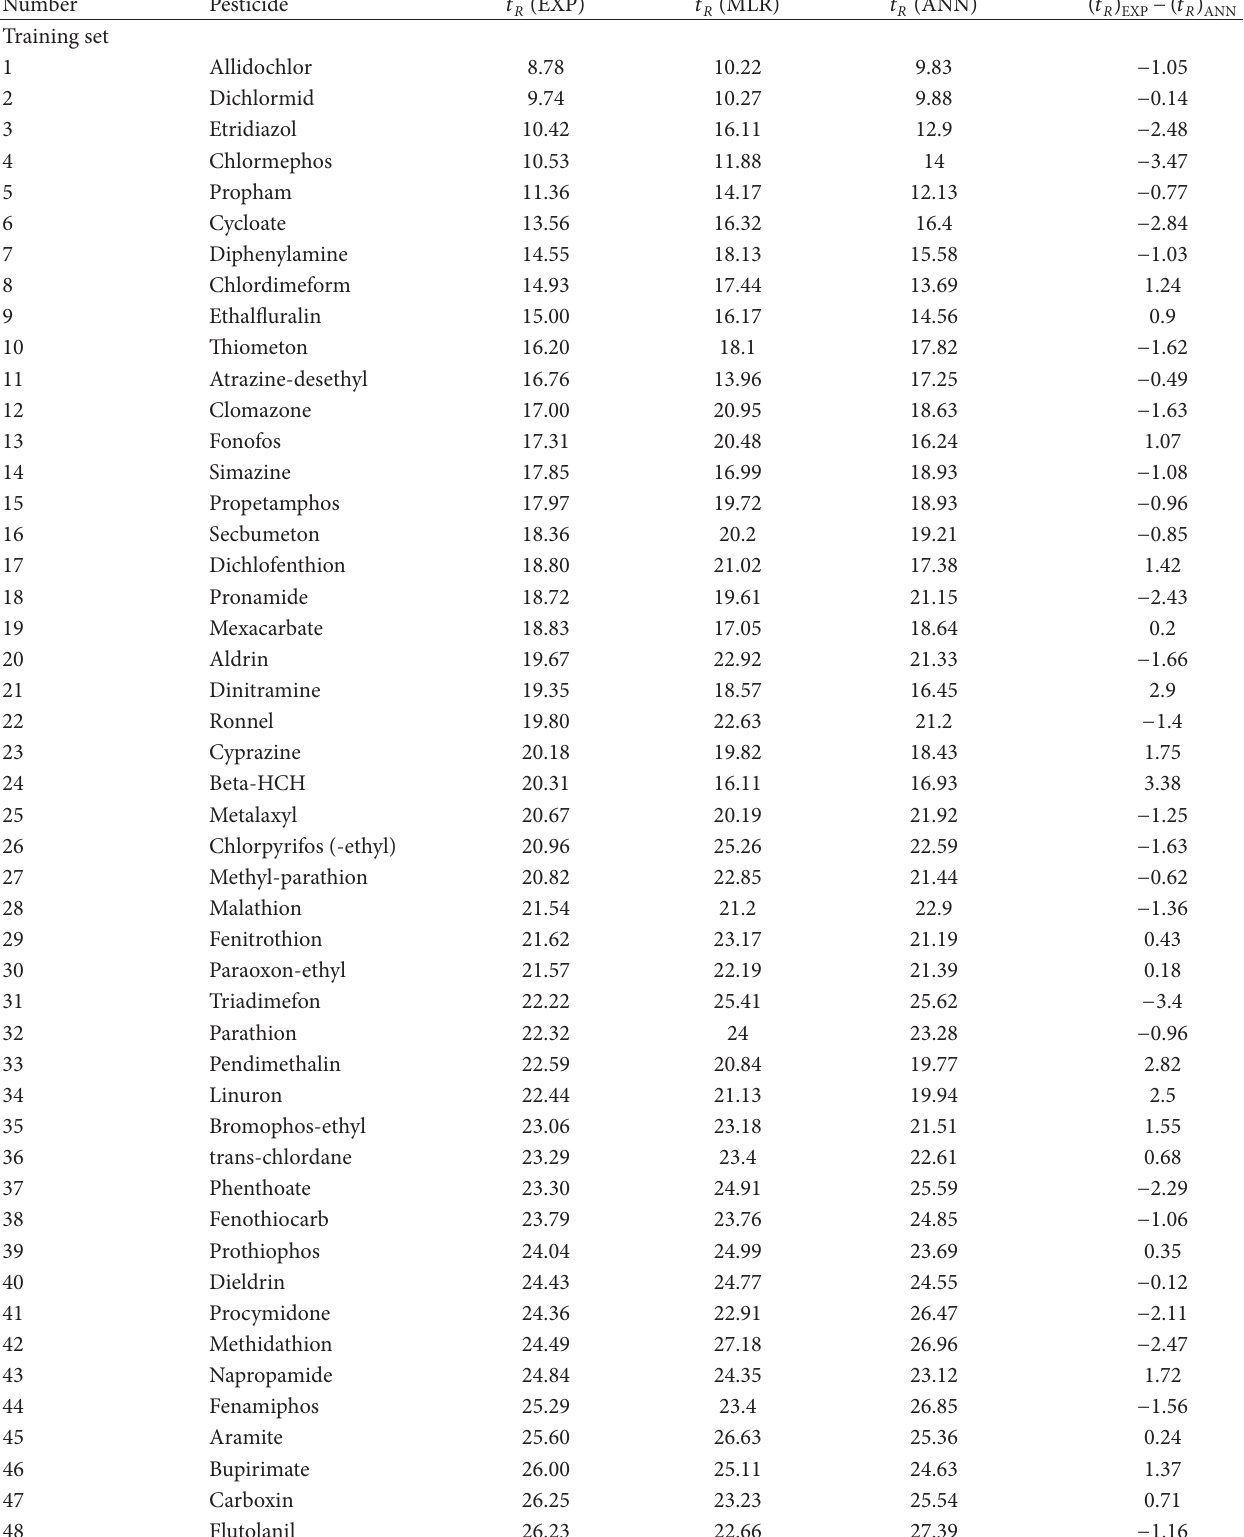
) of training, test, and validation 𝑡𝑡 𝑅𝑅